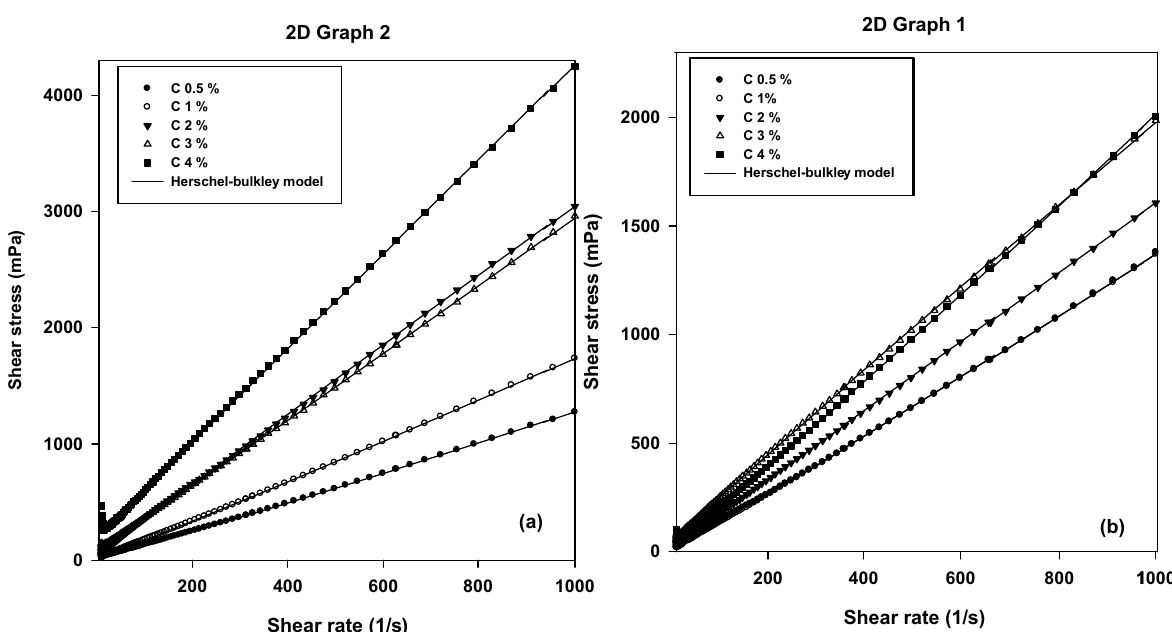
Figure 6: Modeling the rheological behavior of pectin extracted from pumpkin pulp and peel solubilized at various concentrations in 0.2 M citric acid/sodium citrate at 20°C. ( a ) : pulp, ( b ) : ( Table 4 ) . Similar values have been reported by Tonon et al. [ 38 ] for these di ff erent parameters: from 0.39 to 0.97 for the index ( n ) , from 0.17 to 1.28 Pa s n for consistency index ( K and from 2.29 to 4.74 Pa for yield stress.